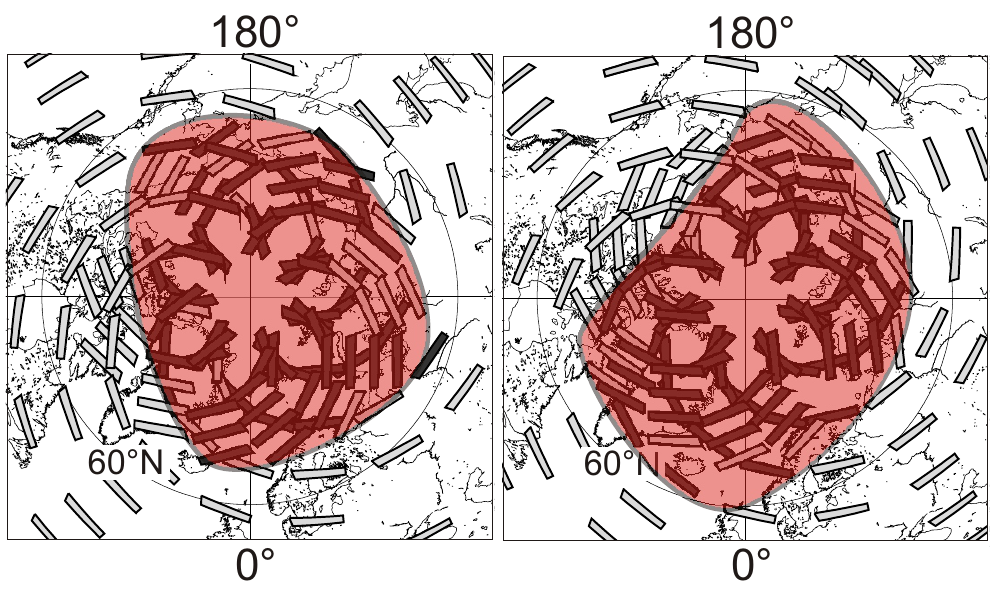
Fig. 2. PMC detection by SCIAMACHY on 3 August (left) and 4 August (right) 2007. Areas where PMC are observed are marked with dark boxes while confirmed absence of PMC is marked with pale boxes. The colored region depicts the PMC area.